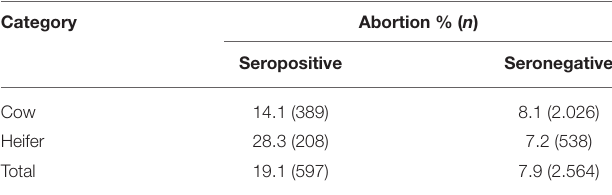
TABLE 1 | Serological diagnosis of N. caninum related abortions in heifers and cows from a dairy herd.